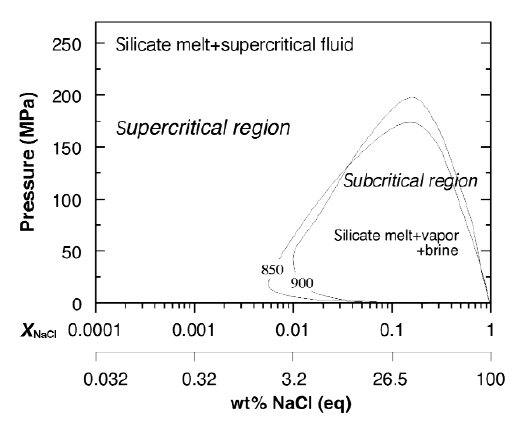
Fig. 1. Pressure- X NaCl diagram of the system NaCl- -H 2 O with 850 and 900°C isotherm (redrawn after Anderko and Pitzer, 1993a). The polythermal projec- tion of the 3-phase vapor + brine + halite equilibrium onto the pressure-composition section is from Bishoff (1991) and Anderko and Pizer (1993a). Experiments with bulk Cl contents that fall within the solvus will coexist with both an aqueous fluid phase (containing a small amount of Cl) and a salt-rich